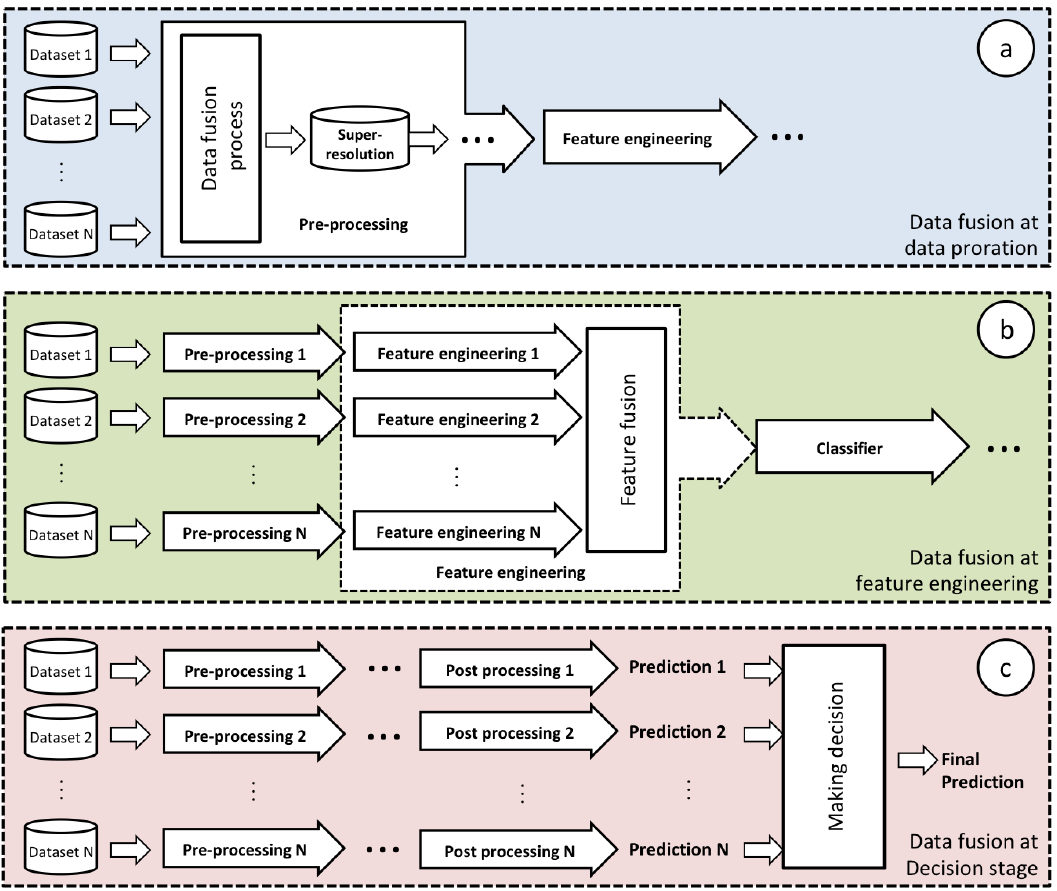
Figure 14. The general schema of multi-modal data fusion at three major stages of the machine learning pipeline: ( a ) Data fusion at the data preparation stage (early fusion). ( b ) Data fusion at the feature engineering stage (feature fusion). ( c ) Data fusion at the very final decision making level (late